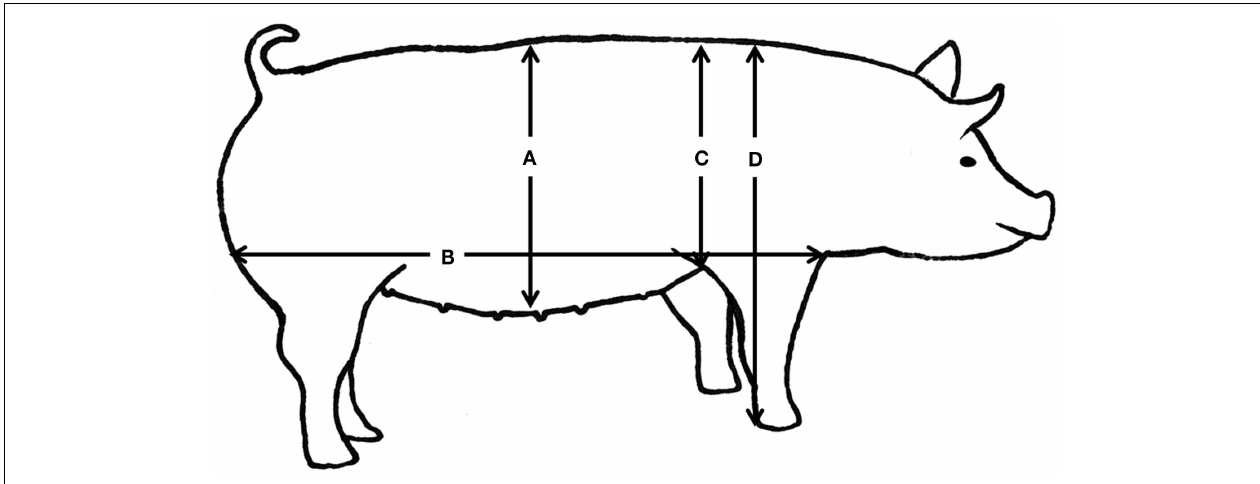
FIGURE 3 | Body conformation measurements in the pig. Body conformation measurements in the pig including abdominal circumference at the navel (A) , the length of the body from rump to the front of the shoulder blade (B) , shoulder height (C) , and thorax height (D)